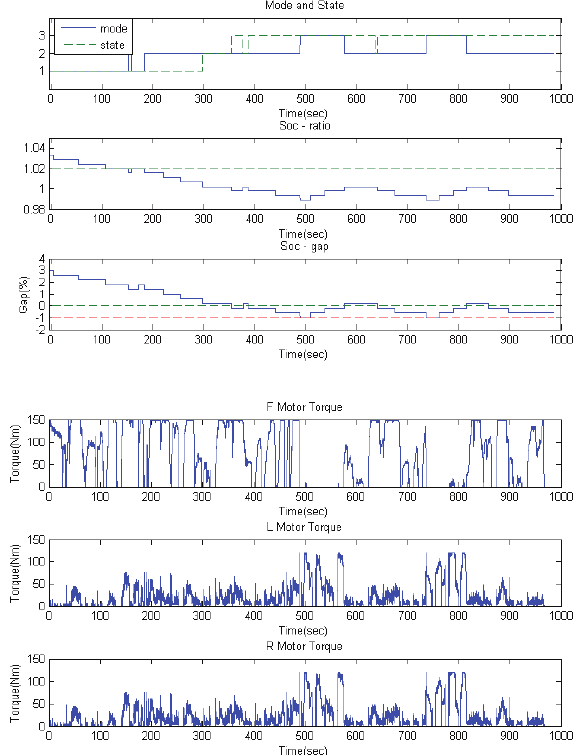
Figure 11. Histories of the mode (solid line), state (dashed line), state of charge (SOC) ratio, SOC gap and the torque distributions of the front, rear left, and rear right motors during torque and battery distribution process for the electric vehicle in the road